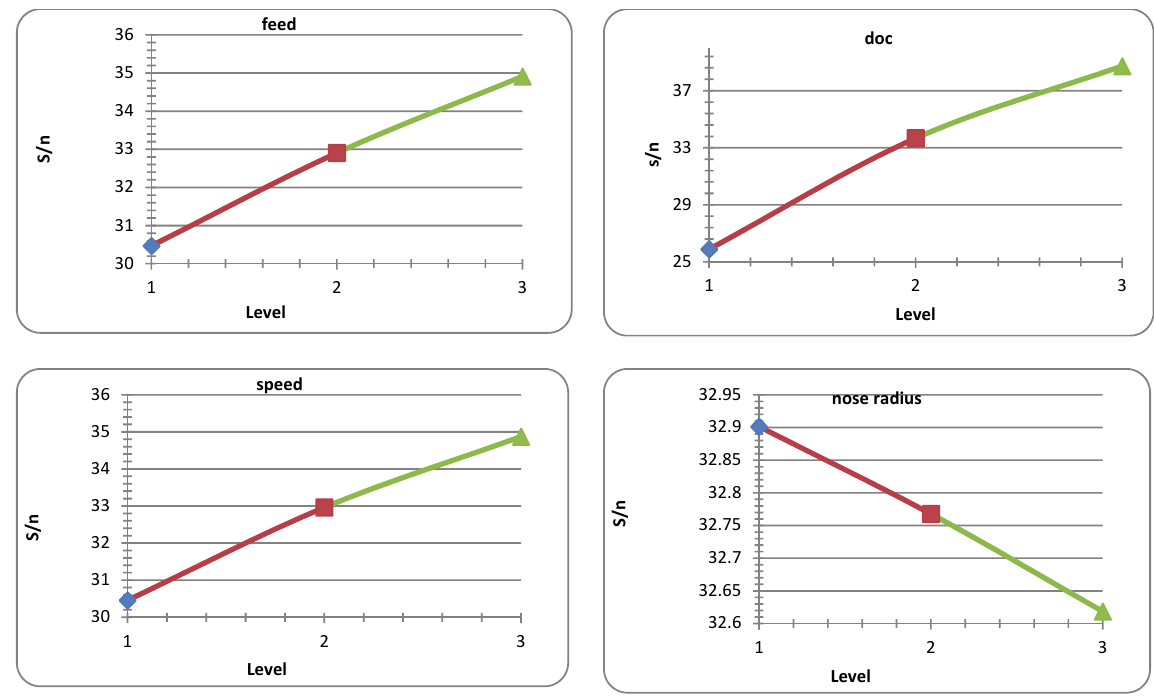
Fig. 3. S/N vs. Parameters showing contribution of the parameters on